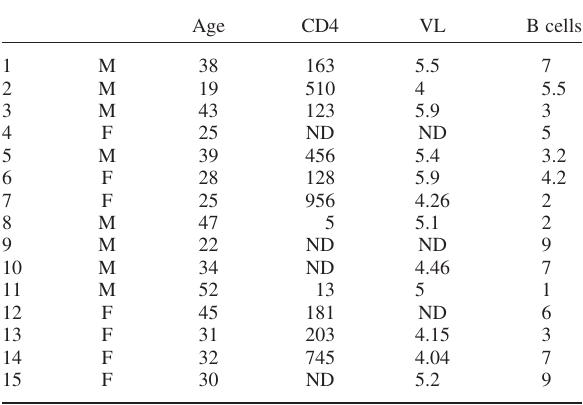
M and F stand for Male and Female; Age is expressed in years; CD4 count is expressedinCD4 þ cells/ m l;plasmaviralloadisexpressedinlog(copies/ml);Bcell is the % of CD20 þ cells within PBMC. ND stands for Not